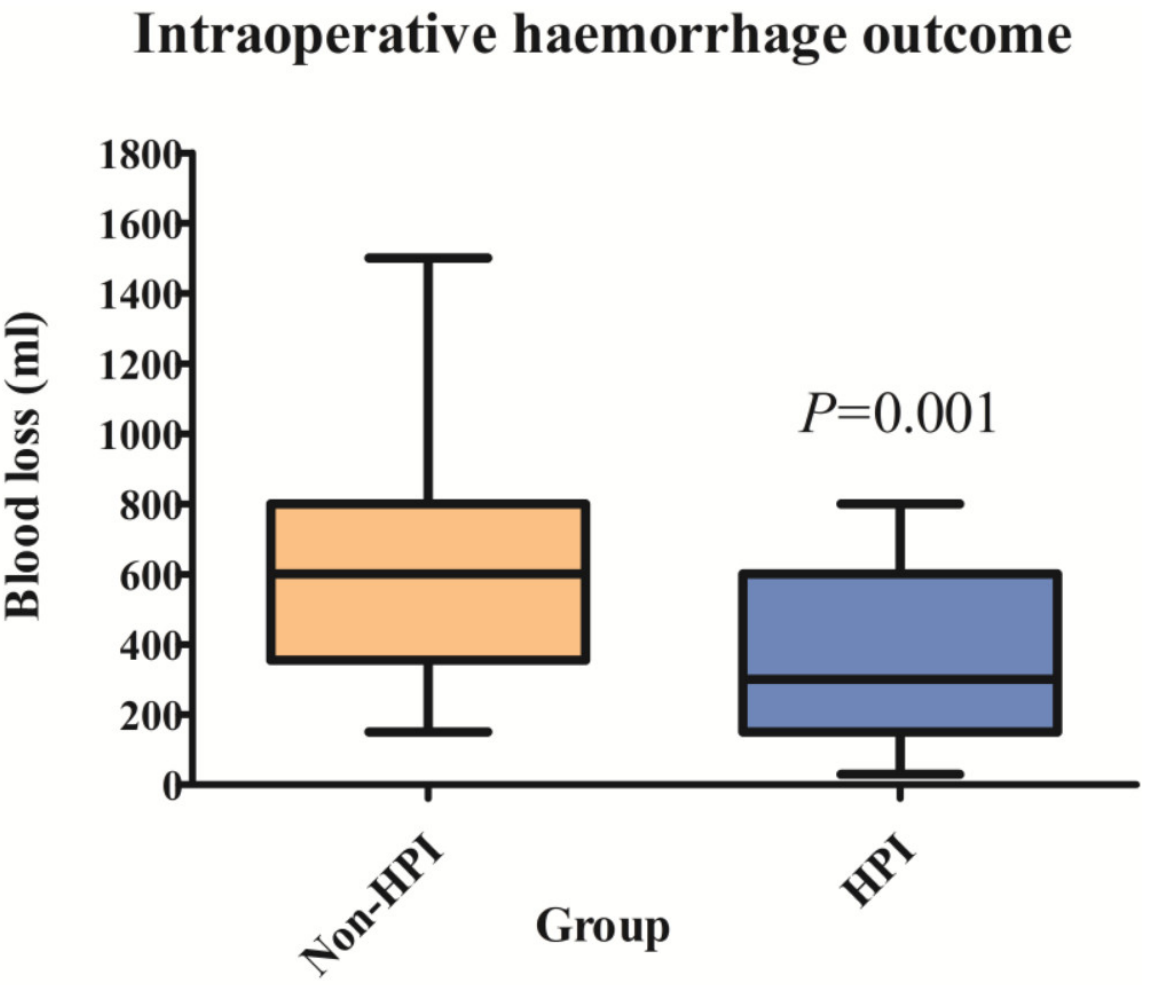
Figure 2. Intraoperative haemorrhage outcome comparing the amount of intraoperative surgical bleeding between the non-HPI group (orange box) and the HPI group (blue box). The mean ± SD intraoperative bleeding was 532 ± 232.7 mL, while the amount of surgical bleeding was 299.3 ± 219.8 mL with a p -value of <0.001. Table 3. Intraoperative haemorrhage outcomes by surgical level.